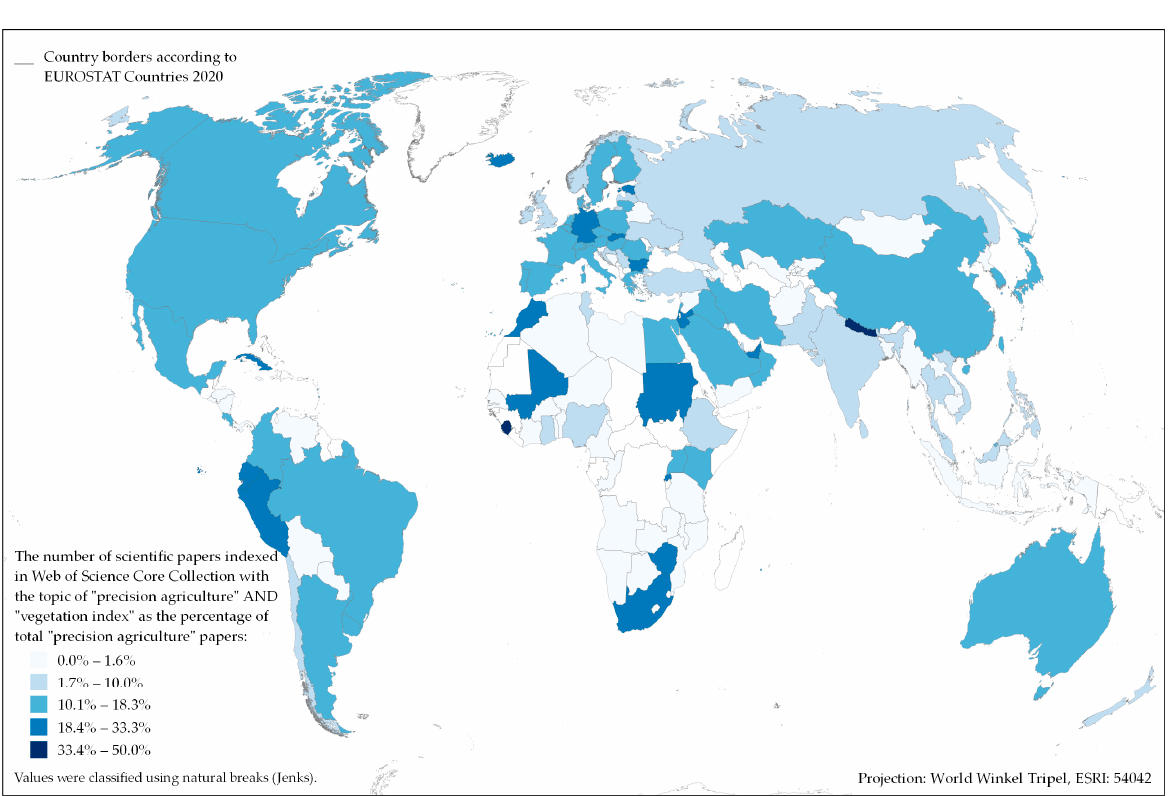
Figure 3. Global map of the number of scientific papers indexed in WoSCC since 2010 with the topic of “precision agriculture” AND “vegetation index”.